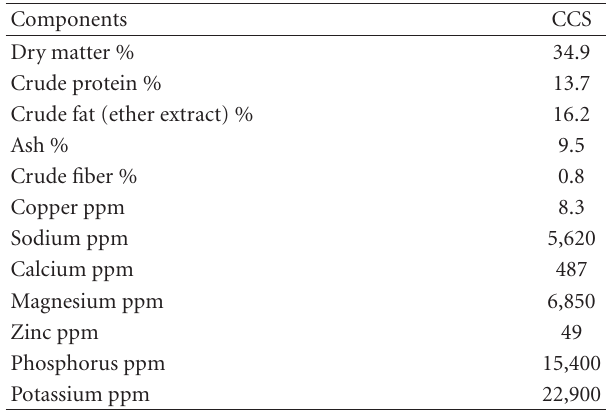
Table 1: CCS composition from a dry mill ethanol